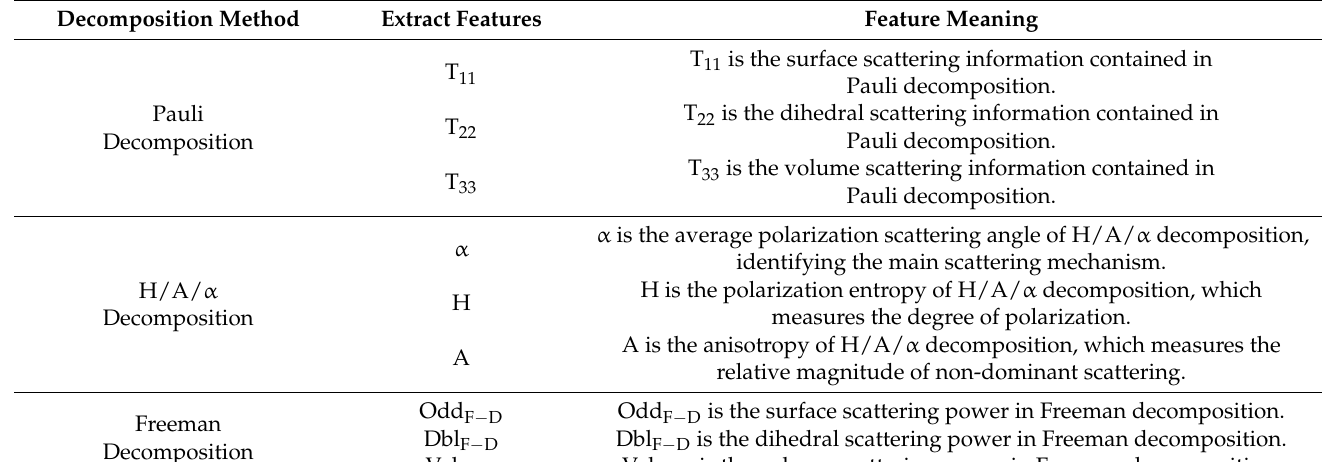
Table 2. Characteristic parameters corresponding to each polarization